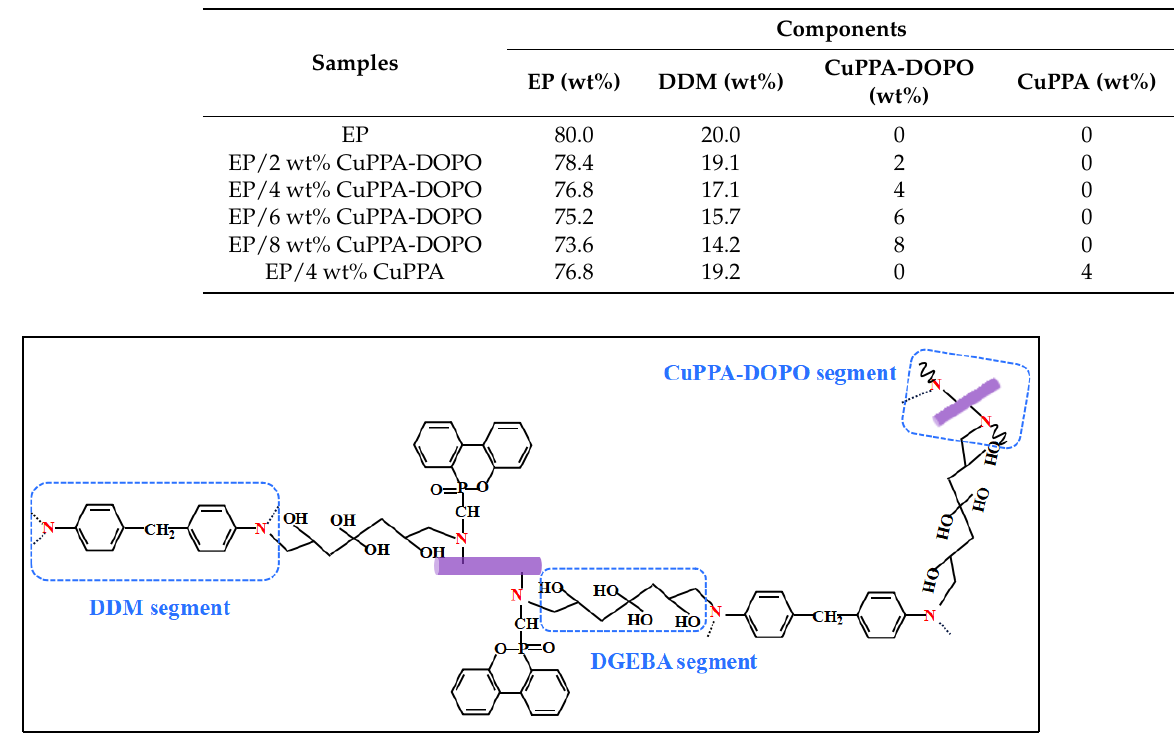
Table 4. Ingredients of EP composites.